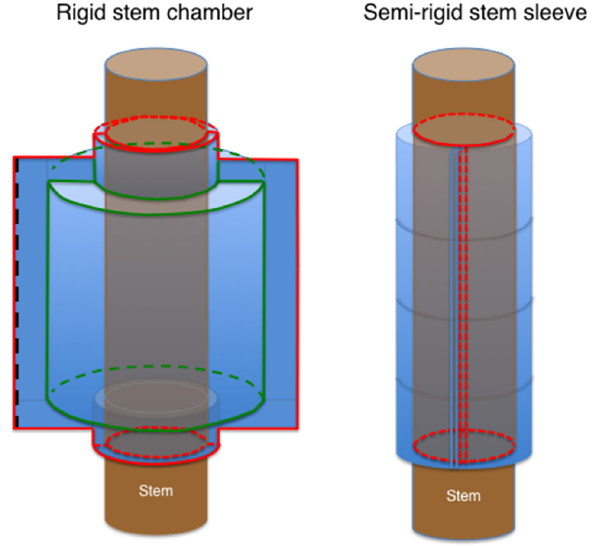
Figure 3. Potential air contact path lines (chamber air versus am- bient air) where gas diffusion can occur; a comparison between the acrylic rigid cylinder approach and the semi-rigid sleeve approach. The red lines represented the mobile contact lines that needed to be sealed properly every time the chambers were deployed and where most of the losses were likely to occur. The green lines represented the fixed contact lines which could have been leaking as a result of twisting forces on the joints leading to